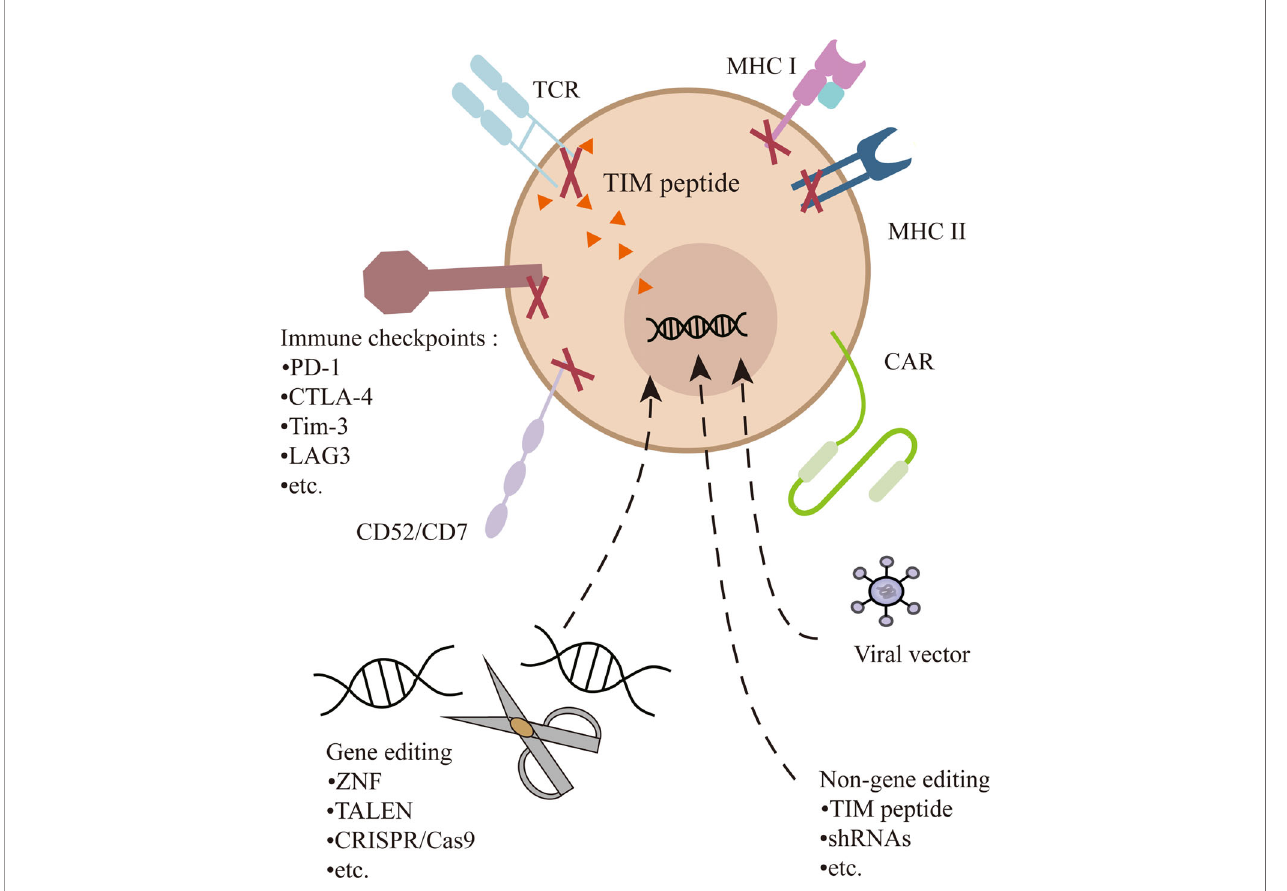
FIGURE 2 | Multiple gene or non-gene editing on UCAR-T cells. In addition to transducing a CAR into T cells, the TCR can be knocked out or inhibited to prevent GVHD. Genetic ablation of MHC-I and/or MHC-II diminish immunogenicity. Destruction of CD52 can make cells resistant to alemtuzumab. CD7 is edited to prevent the fratricide in CD7 UCAR-T cells. In addition, inhibitory checkpoints (e.g., PD-1) can be knocked out to enhance the function of